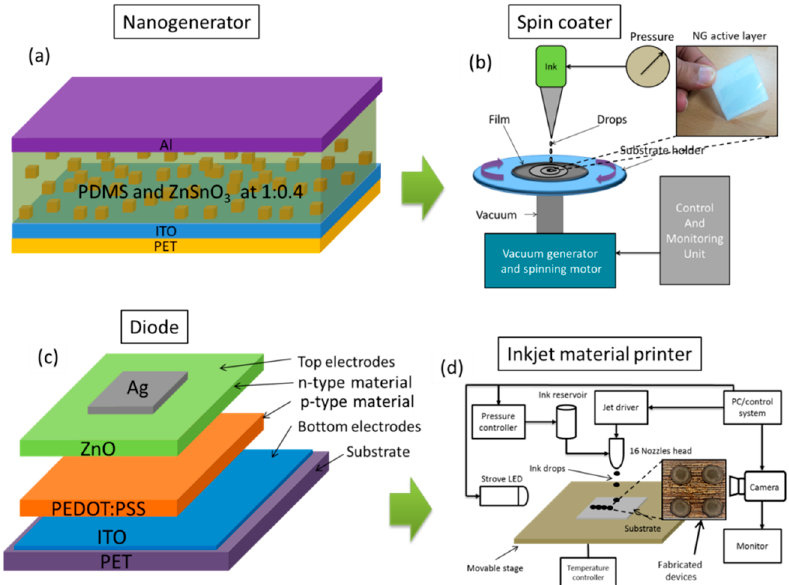
Figure 2. ( a ) NG layout diagram fabricated layer by layer. ( b ) NG fabrication with a spin coater. ( c ) Materials layout diagram of the diode device. ( d ) Schematic diagram of the inkjet material printer.